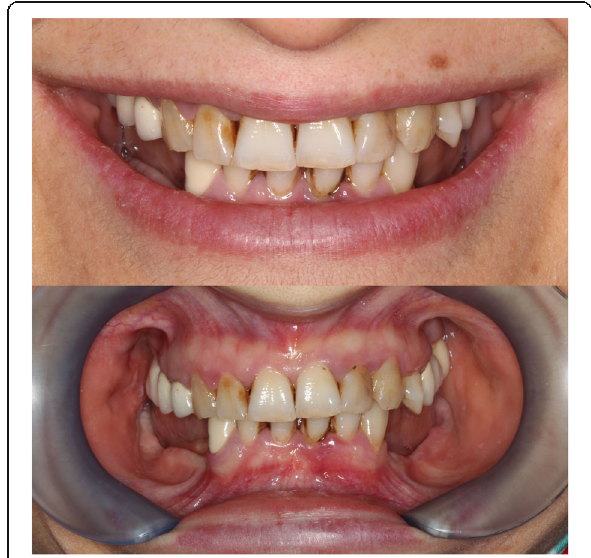
Fig. 2 Clinical view of patient 1 in diagnosis and treatment planning stage